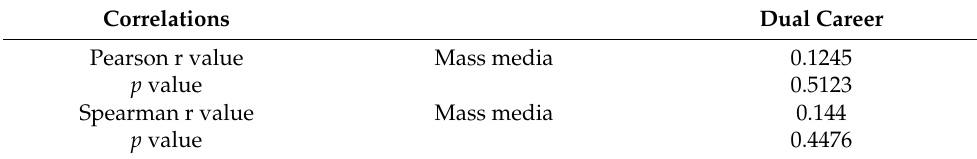
Table 6. Pearson and Spearman correlation for dual career.